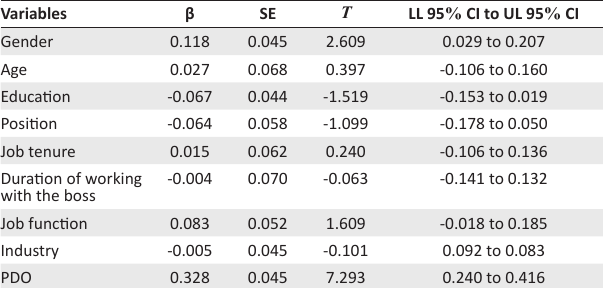
TABLE 4: Structural equation model results for power distance orientation.